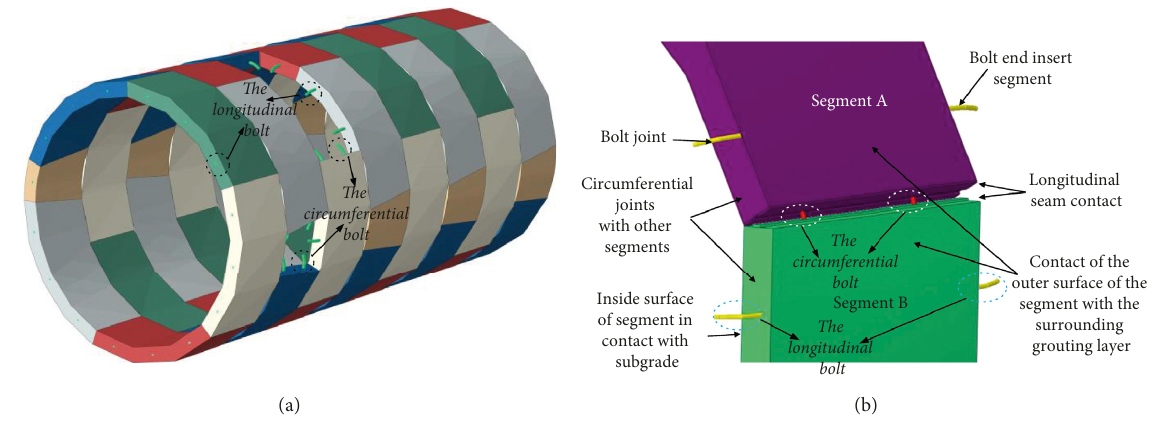
Figure 7: Contact relationship between grouting layer, segment, and surrounding rock. (a) Segment lining model and (b) contact